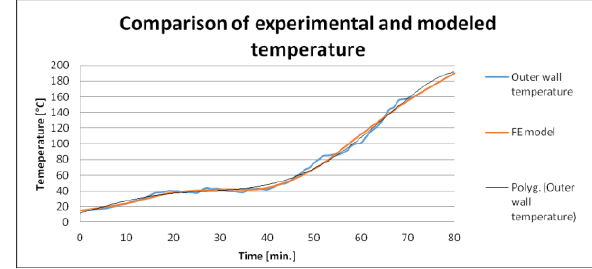
Fig. 6. and 7. Temperatures at time 0 and 10 min.